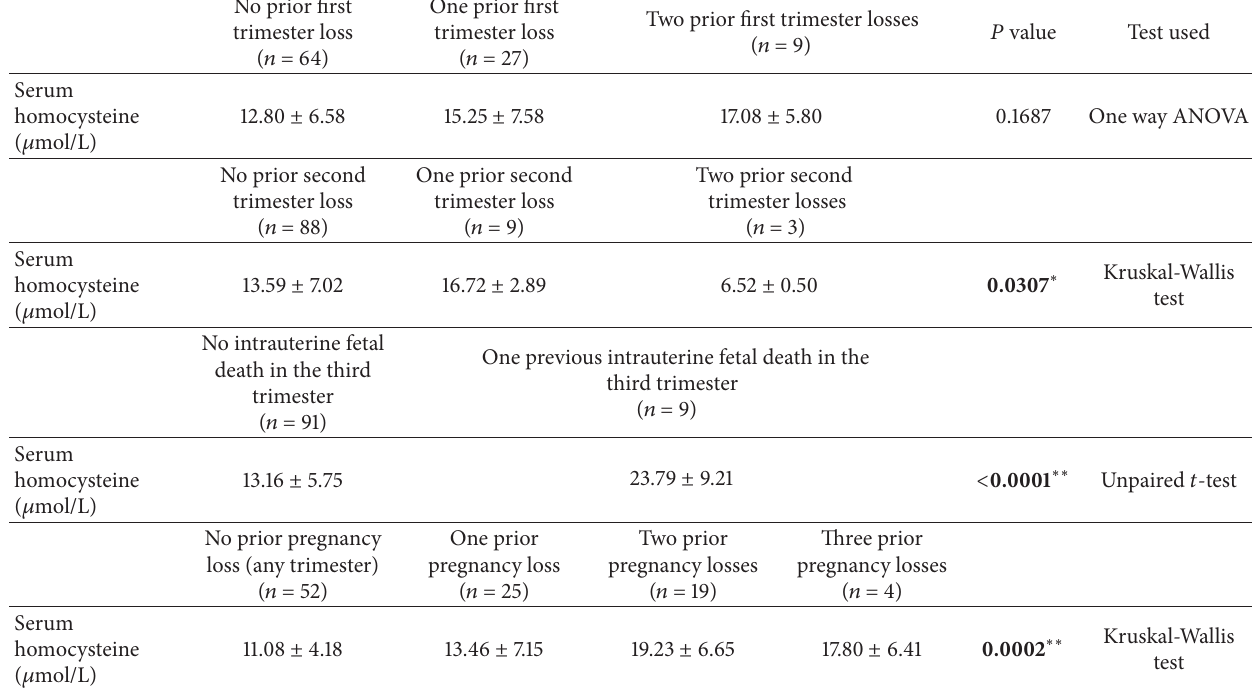
Table 2: Homocysteine levels with reference to outcome of past